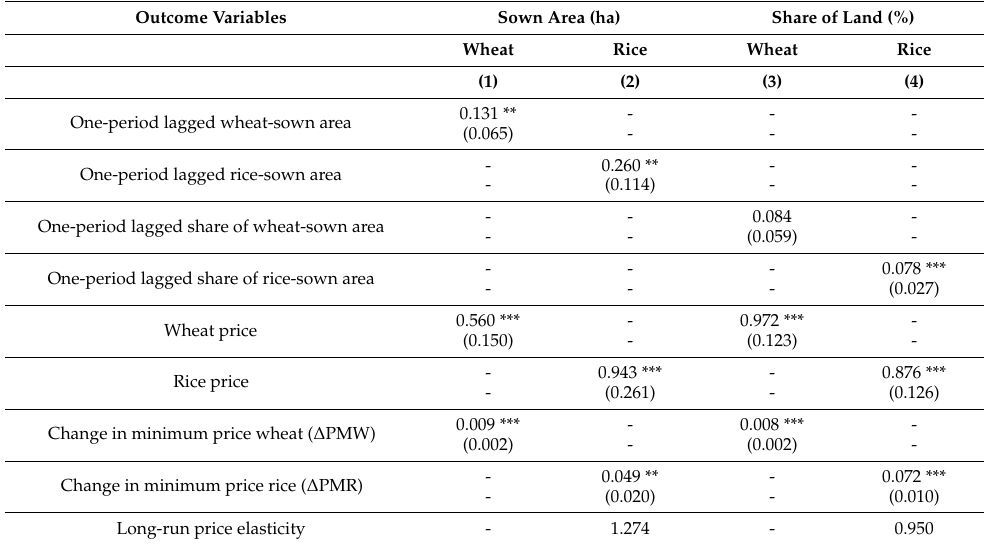
Table A1. Estimated elasticities for sown land areas.